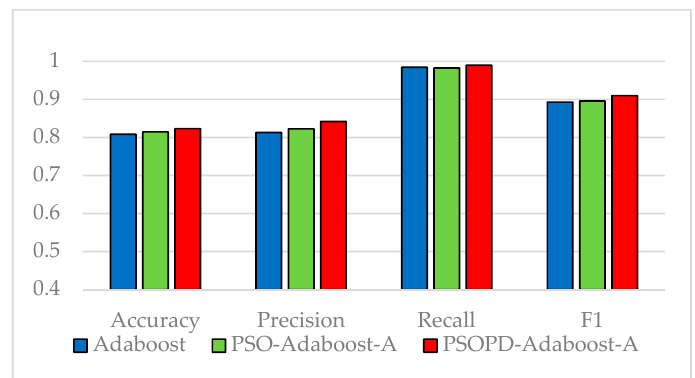
Figure 10. Performance Comparison of the AdaBoost, PSO-AdaBoost-A, and PSOPD-AdaBoost-A on Ionosphere Dataset.